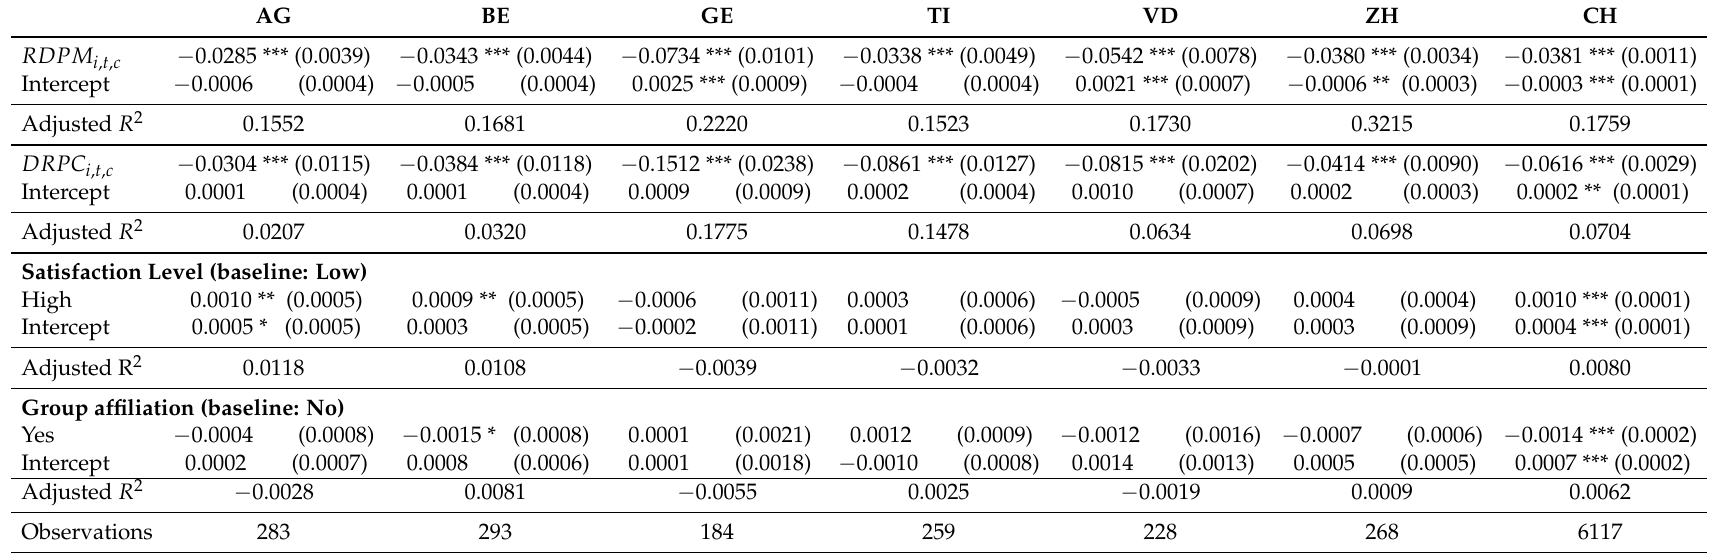
Table A3. Single variable regression results ( R 1) with normally distributed residuals.